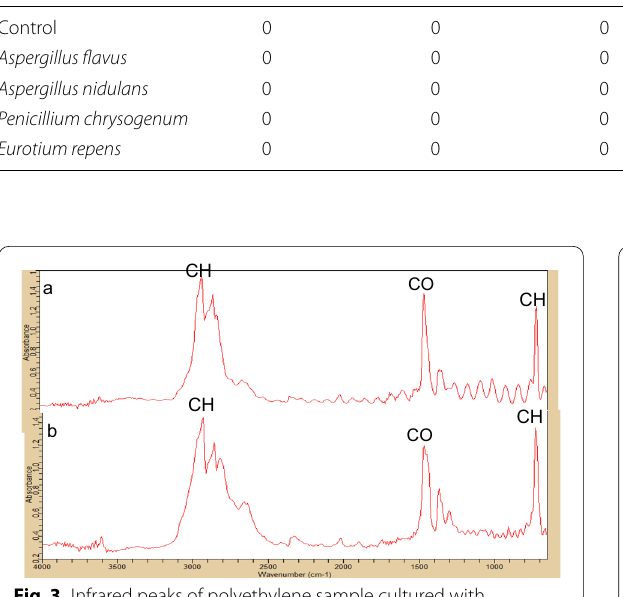
Fig. 3 Infrared peaks of polyethylene sample cultured with Aspergillus flavus ( a ) and control sample ( b )